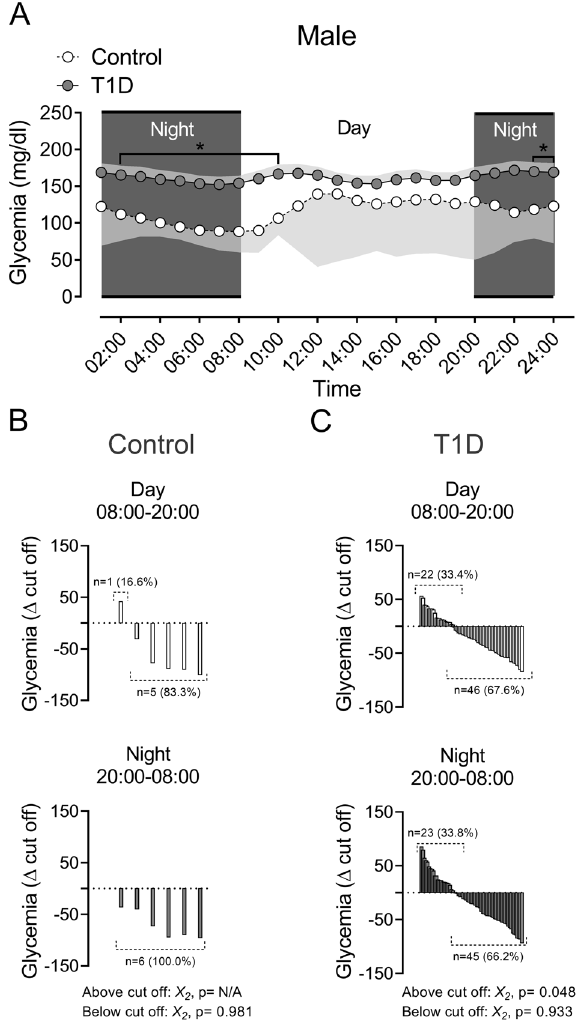
Figure 5. Circadian rhythm of glycemia and magnitude of hyperglycemia and euglycemia events during day and night phases in males T1D and control participant. ( A ) During day phase, T1D male patients showed a significant difference compared to their matched control group between 09:00 to 10:00. During night phases, males with T1D patients showed a significant difference compared to their matched control group between 21:00 to 08:00 (Two ways ANOVA, following Fisher posthoc; F (DFn: 2, DFd: 85) = 4.42; p = 0.015). ( B , C ) Magnitude of hyperglycemias and euglycemia’s during day and night phases, in Control and T1D males’ patients, respectively. Note that T1D male patients display a significant difference on hyperglycemias during day and night phases (Wilcoxon rank test, p =